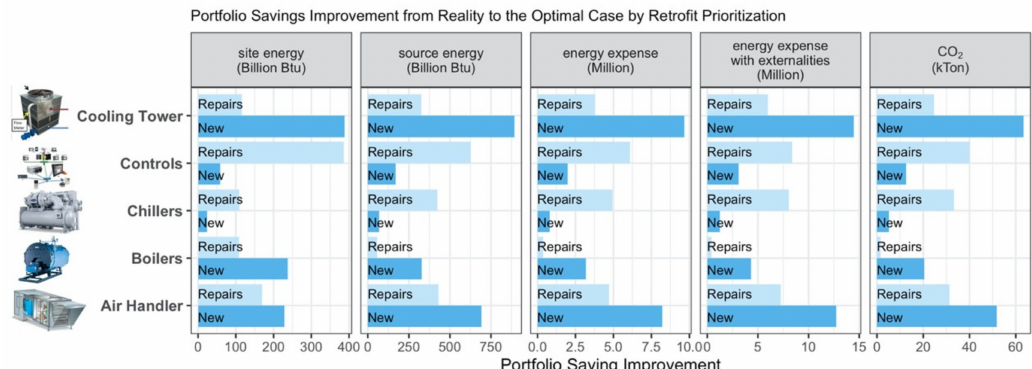
Figure 13. The benefit of targeting for HVAC retrofit sub-actions (1 billion Btu = 1055 billion joules).